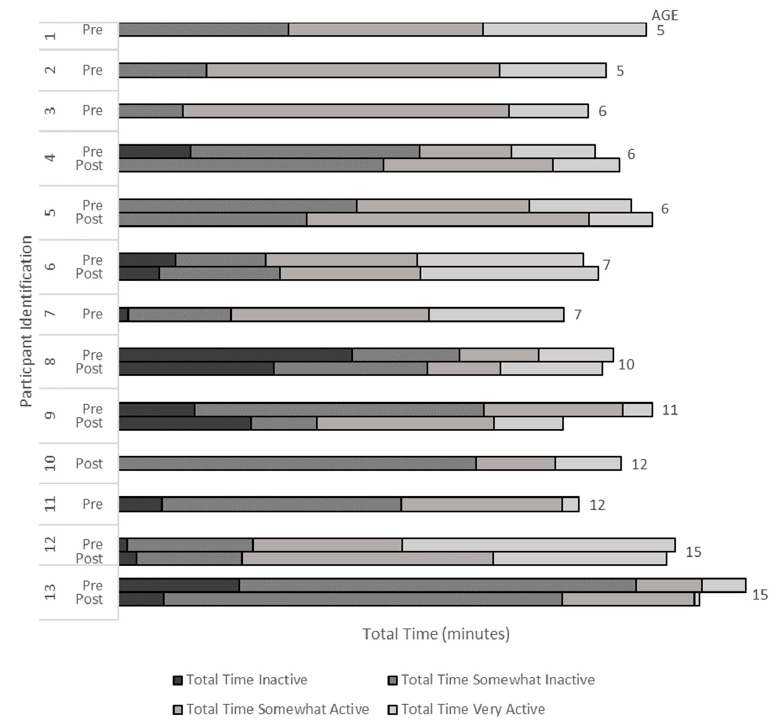
Figure 1. The 7-Day Physical Activity in Total Time (minutes) Reported by Youth in the Habitual Activity Estimation Scale.